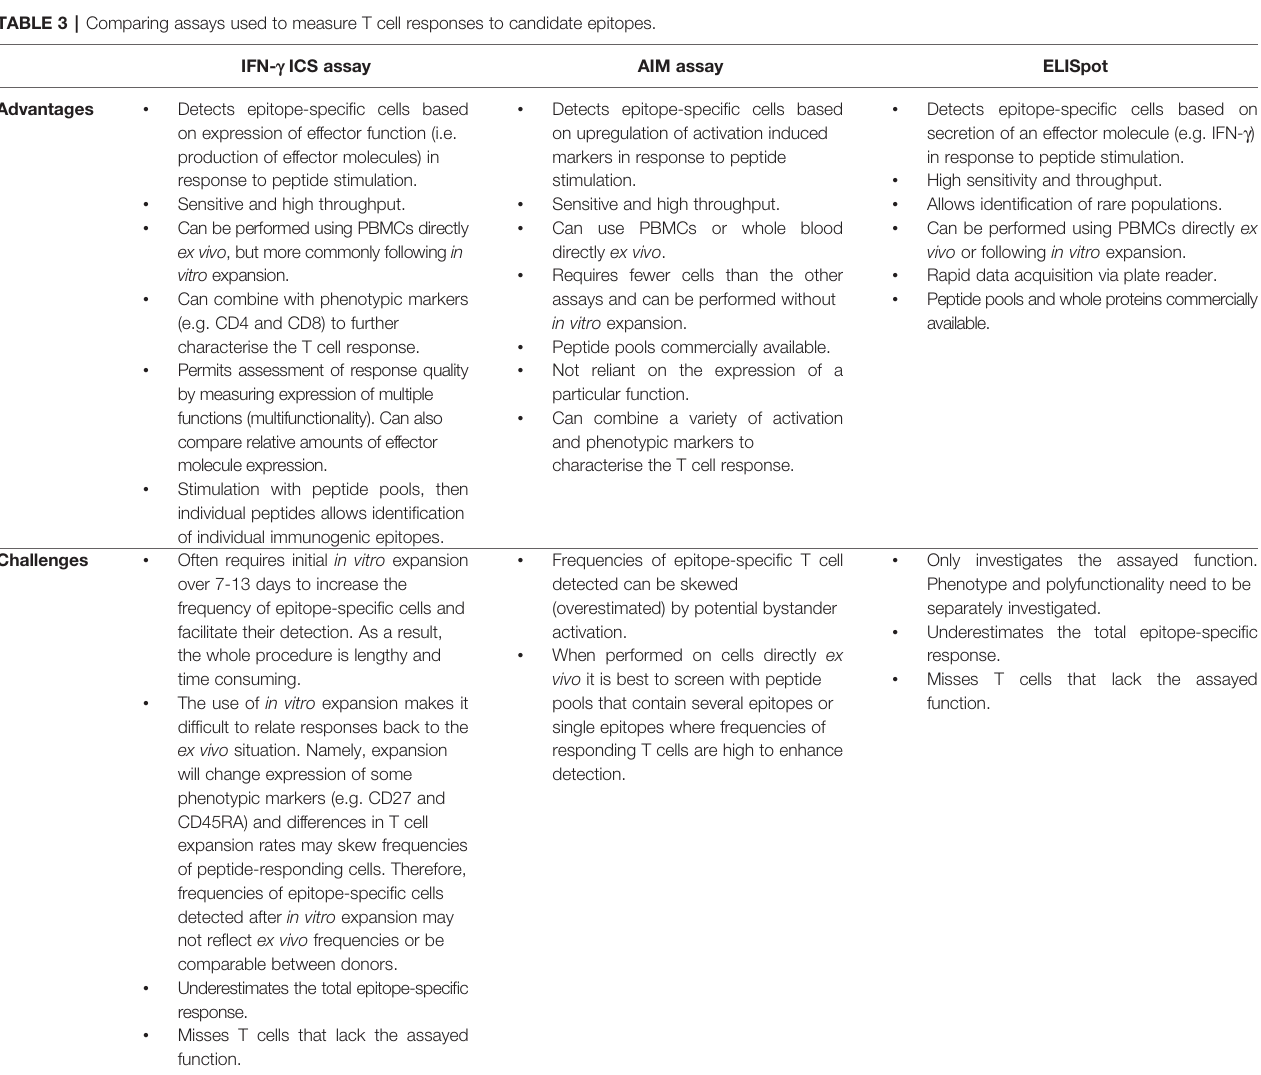
TABLE 3 | Comparing assays used to measure T cell responses to candidate epitopes. IFN- g ICS assay AIM